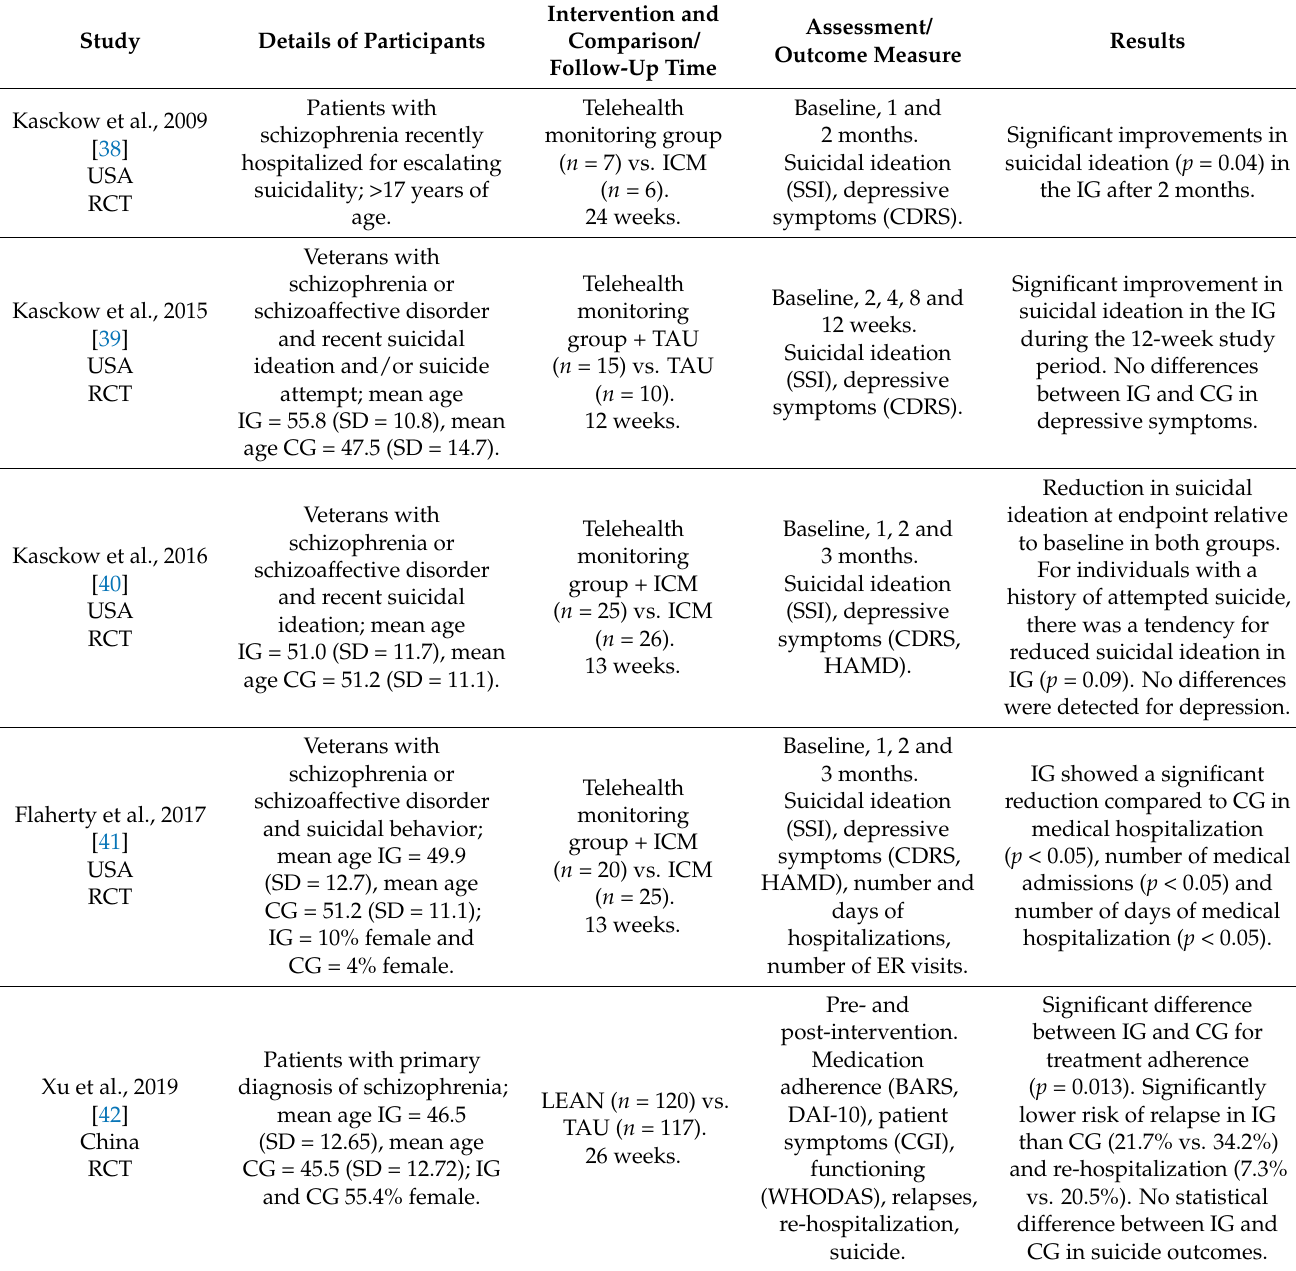
Table 1. Participants, interventions, comparisons, outcomes and study designs (PICOS) overview for the included articles ( n =